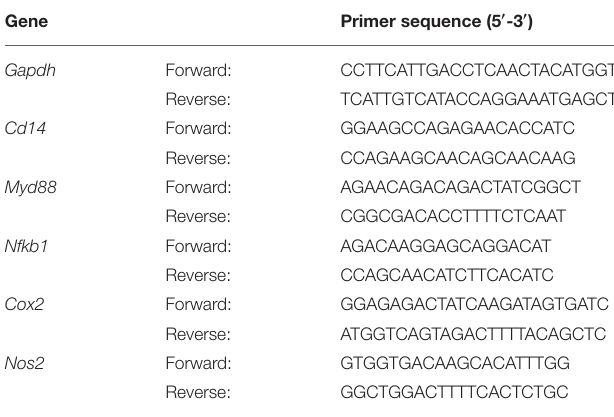
TABLE 1 | List of primer sequences of genes used in this study. Gene Primer sequence (5 ′ -3 ′